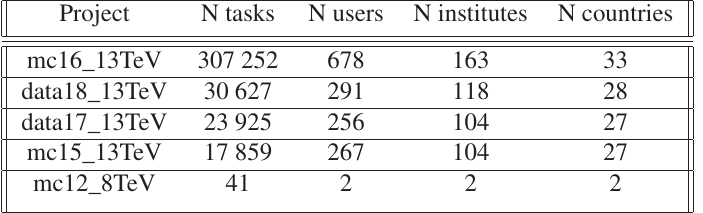
Table 1: Popularity Metrics by Projects [October 2020–January 2021] Project